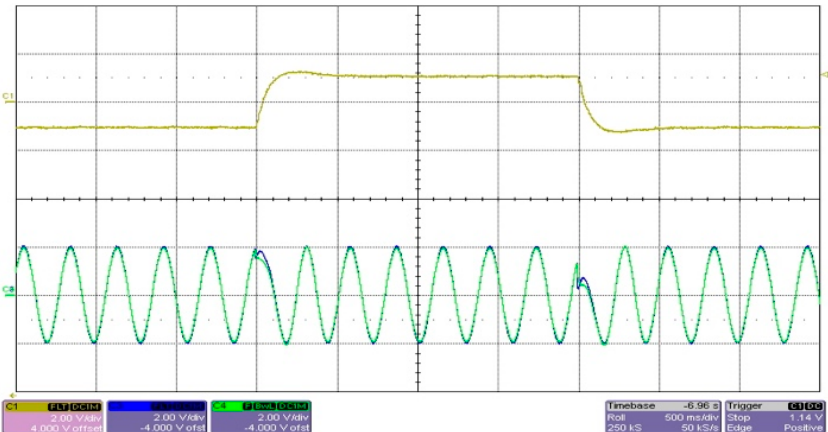
Figure 11. Experimental result: current sensorless control using estimated stator currents when all current sensors fail—speed reversal to ±100 rpm, no load. Measured rotor speed (yellow), measured (blue) and estimated (green) a-phase stator current. Scales: speeds—200 rpm/div; currents—2 A/div; time—500 ms/div.